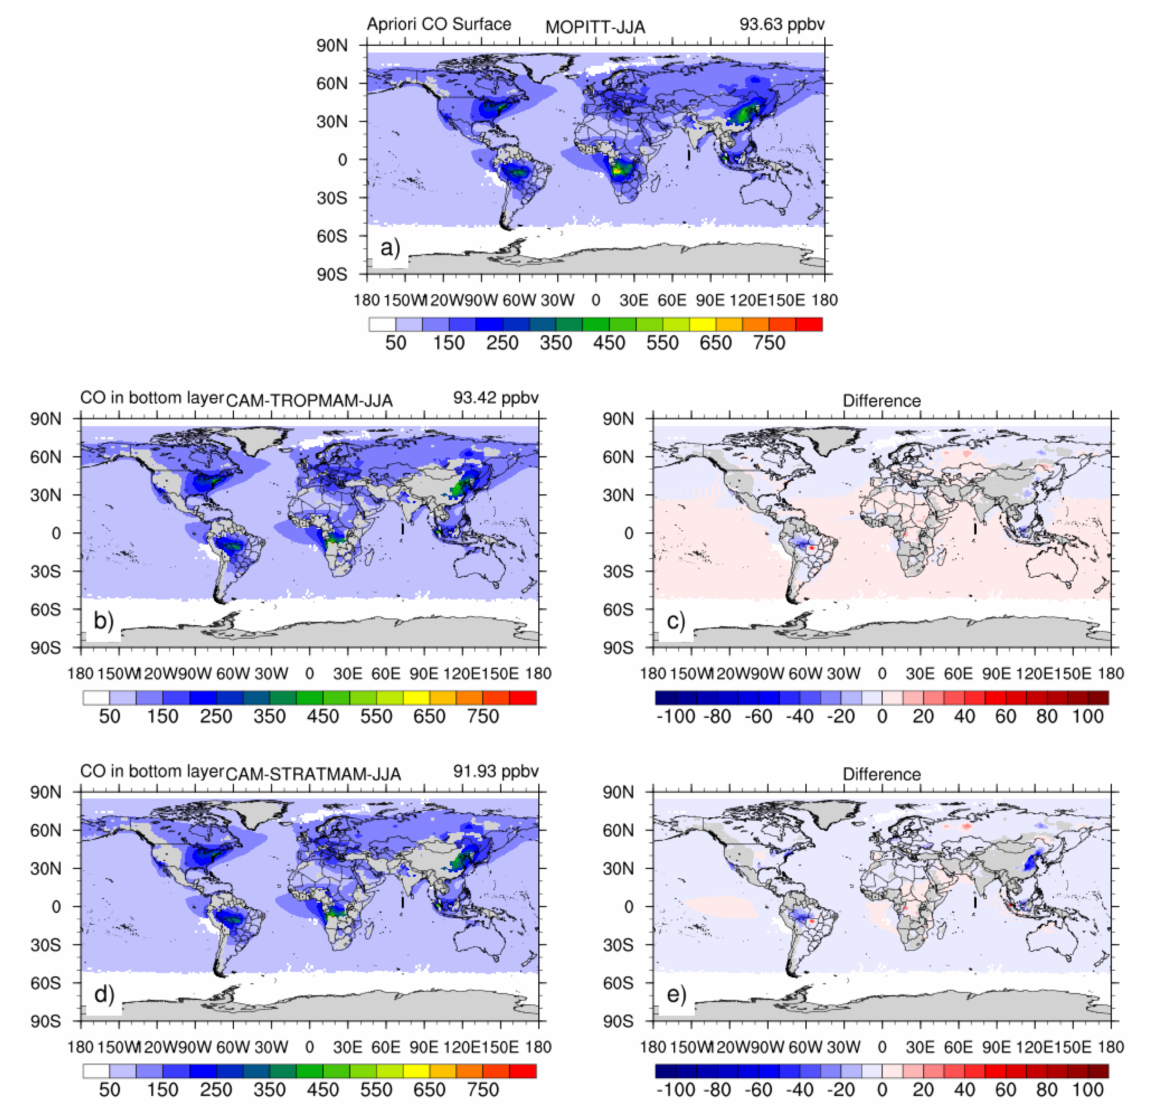
Figure 3. ( a ) CO (ppb) observed by MOPITT sensor for June-July-August (JJA), in the period of 2010–2014, ( b ) CO simulated by the CAM5-MAM3 model using tropospheric chemistry and ( d ) tropospheric/stratospheric chemistry mechanisms using the calculations of Equation (4). The right side of the figure shows the model difference minus the observation (MOPITT), ( c ) for tropospheric chemistry and ( e ) for tropospheric/stratospheric